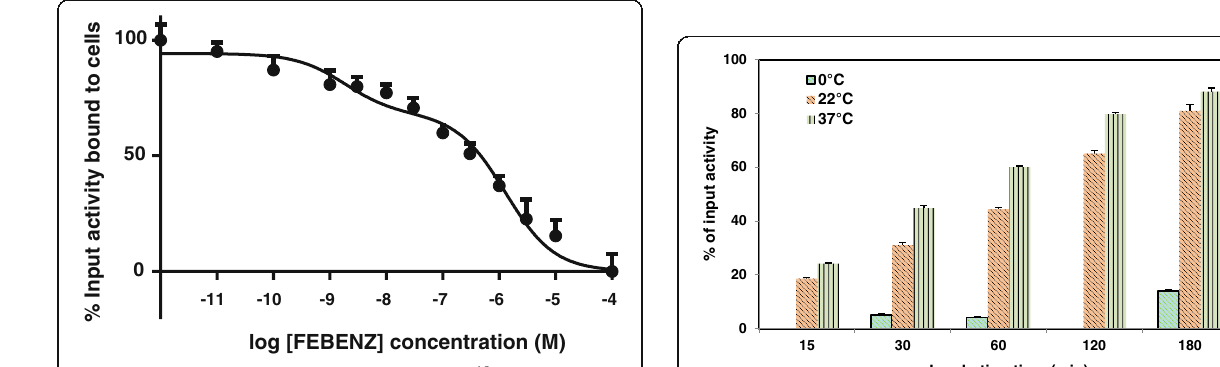
Fig. 3 Results from homologs competition of 4-[ 18 F]FEBZA for the varying concentration of FEBZA binding to B16F1 cells. The B16F1 cells were incubated with non-radioactive FEBZA (10 − 11 M – 10 − 4 M) at room temp for 1 h followed by adding a fixed amount of 4-[ 18 F]FEBZA to each well. Each data point (mean ± SD; n = 4 wells) represents the percent of added 4-[ 18 F]FEBZA bound to the cells in presence of varying concentration of non-radioactive FEBZA